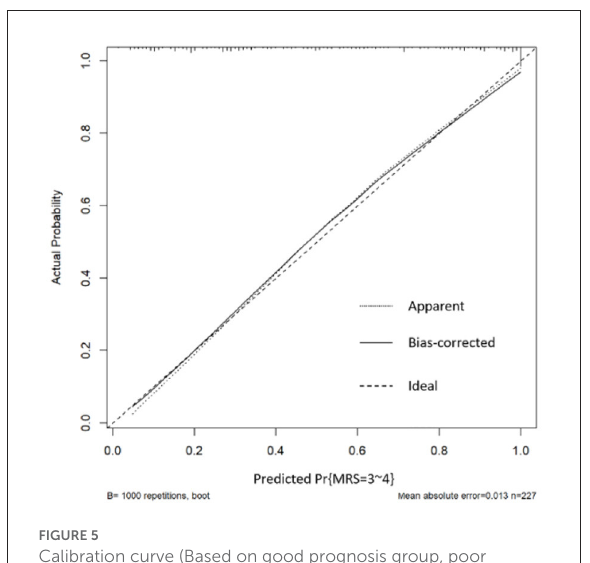
FIGURE5 Calibration curve (Based on good prognosis group, poor prognosis group).